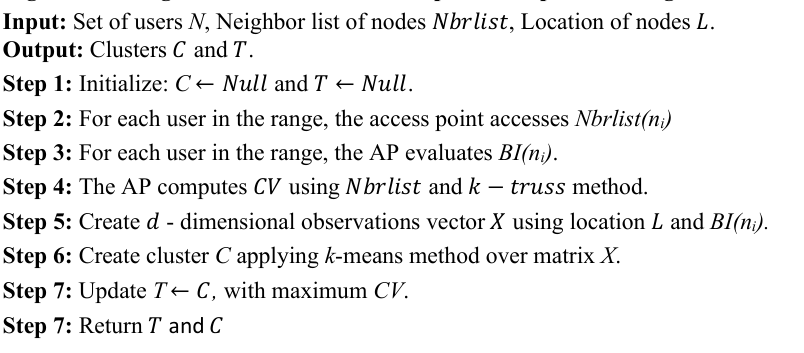
Algorithm 1. Algorithm executed at access point for optimized target set identification